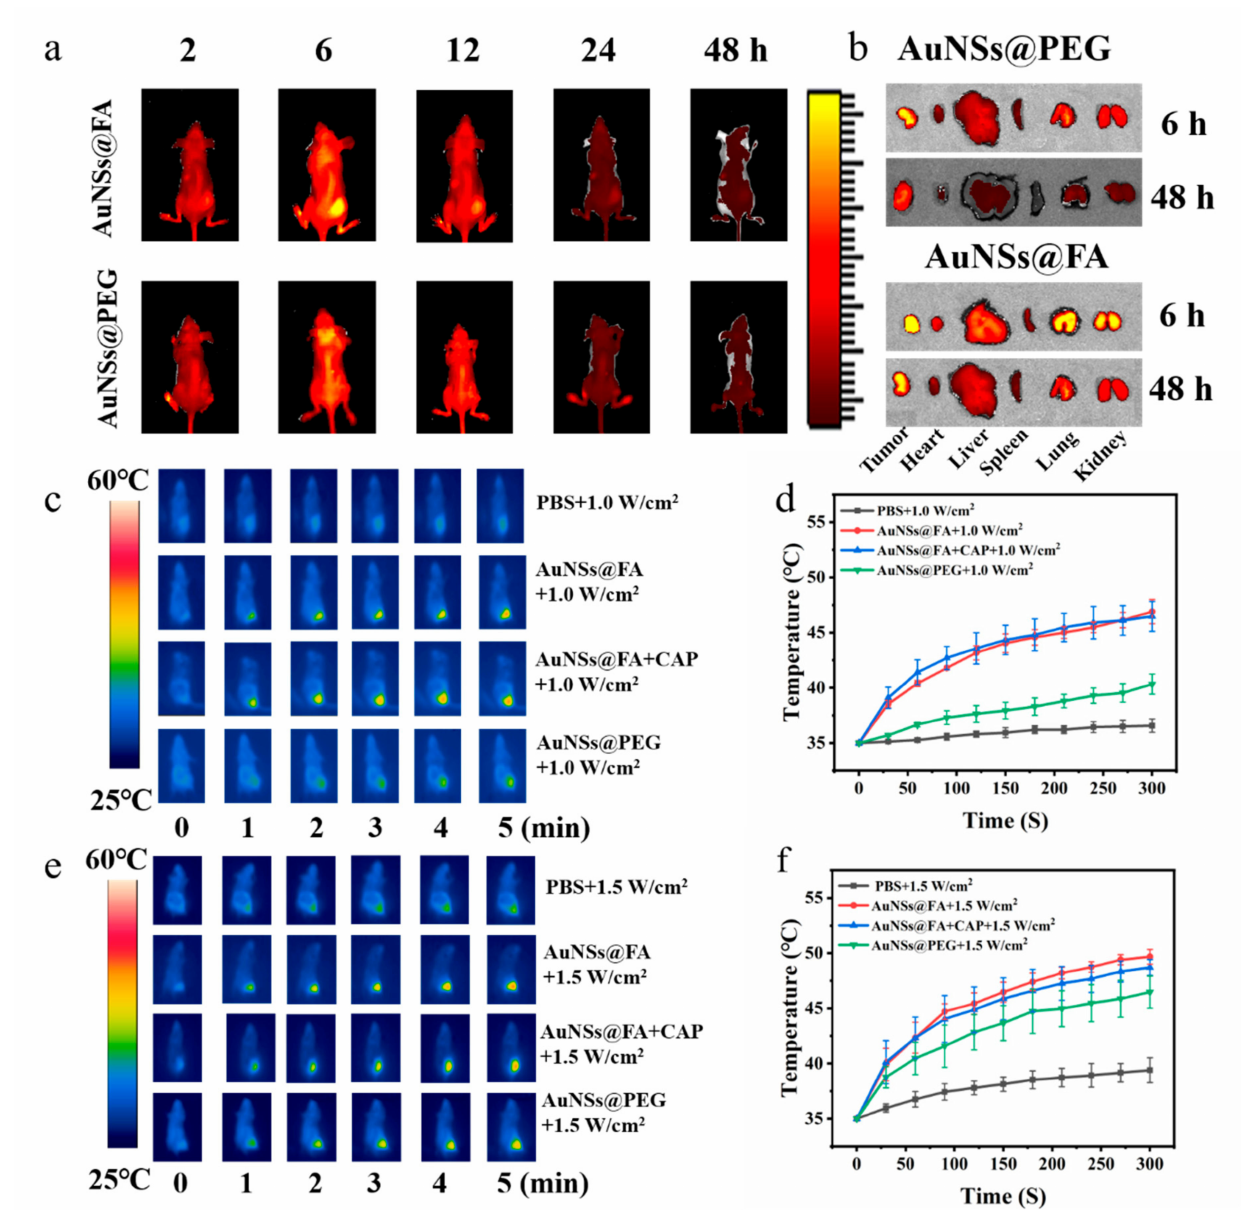
Figure 6. ( a , b ) Biodistributions of AuNSs@FA and AuNSs@PEG in tumor-bearing nude mice at different points in time (2, 6, 12, 24, 48 h), in the tumor and in the major organs collected at 6 h and 48 h. Infrared thermal images in vivo ( c , e ) and the temperature evolution curves ( d , f ) treated with PBS, AuNSs@FA, AuNSs@FA+CAP, and AuNSs@PEG under 808-nanometerlaser irradiation at 1.0 and 1.5 W/cm 2 , respectively, within 5